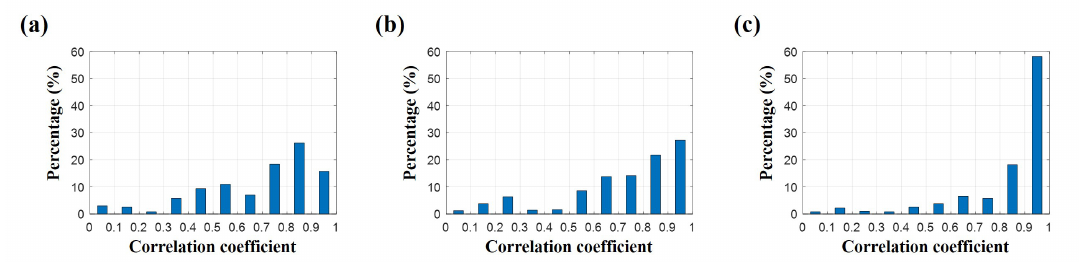
Figure 13. Arrivals less than 30 ◦ are used for the inversion of sound speed profile. Percentages of cases corresponding to correlation coefficients ( x -axis) according to three numerical experiments using different objective functions. Limited information related to the position is used for ( a ) and all available information is used ( b ) without and ( c ) with the normalization, respectively.